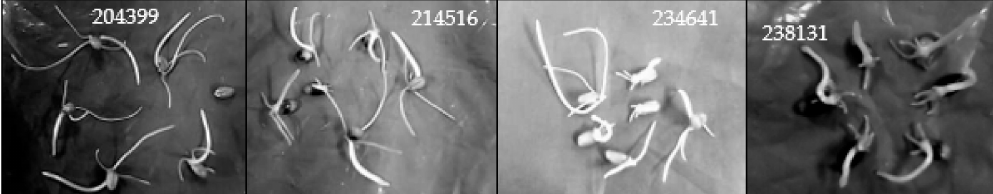
Figure 1. Examples of seedlings grown for 5 days in Al 3 + -containing nutrient solution. Accessions